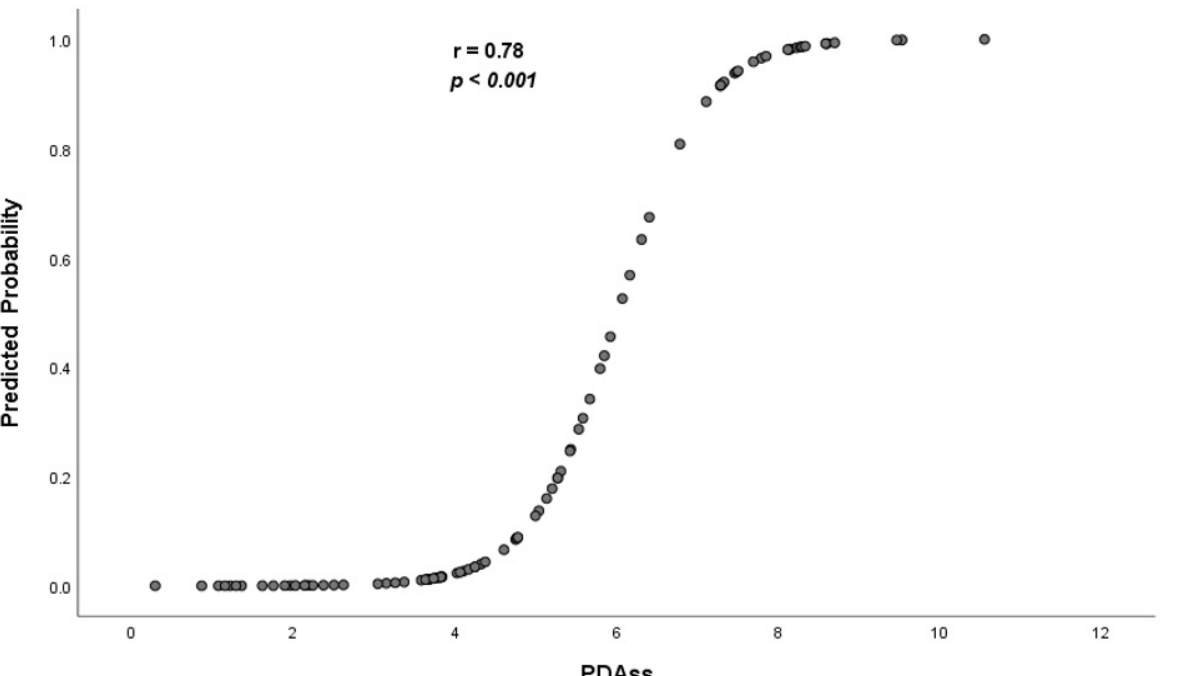
Figure 2. Difference in PDAss between infants with and without CLD/death.